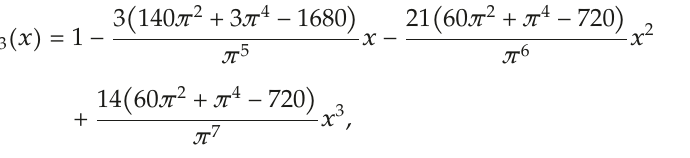
Table 1: The residual error (cid:5) sin c (cid:2) x (cid:6) − p polynomial of degree n and sinc (cid:2) x (cid:6) with the square norm on interval (cid:2) 0 ,π/ 2 (cid:3) , where n (cid:7) 2 , 3 , 4 ,